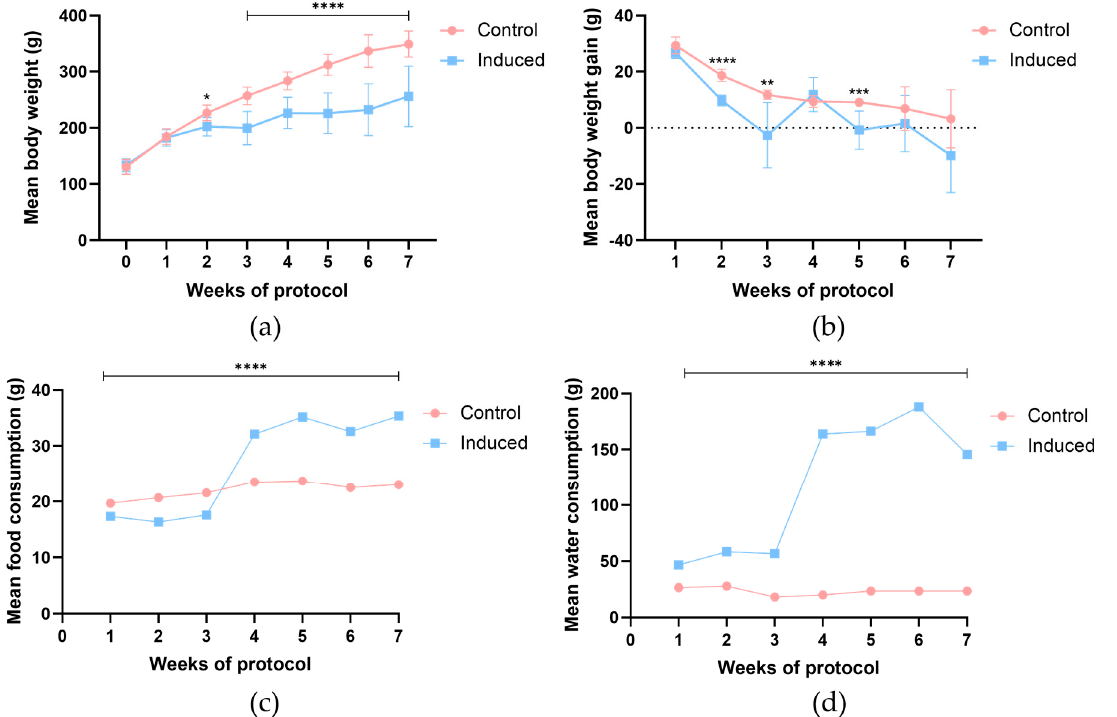
Figure 2. ( a ) Mean body weight of each group, ( b ) mean body weight gain, ( c ) mean food and ( d ) water consumption per day throughout the trial in both experimental groups. * Statistically different from control group ( p < 0.05); ** p < 0.01; *** p < 0.001; **** p < 0.0001. The group control (n = 8) was intraperitoneally administrated with 0.1 M citrate buffer, while the induced group (n = 16) was intraperitoneally administrated with STZ diluted in 0.1 M citrate buffer after fructose feeding. Data are presented as mean ± standard deviation